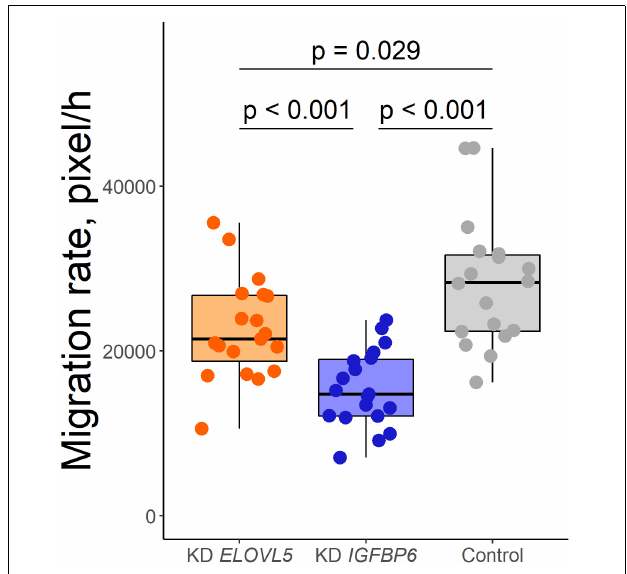
FIGURE 5 | Boxplot of cell migration activity according to the scratch wound healing assay ( n = 19, n = 19, and n = 18 wells for KD ELOVL5 , KD IGFBP6 , and control cells,